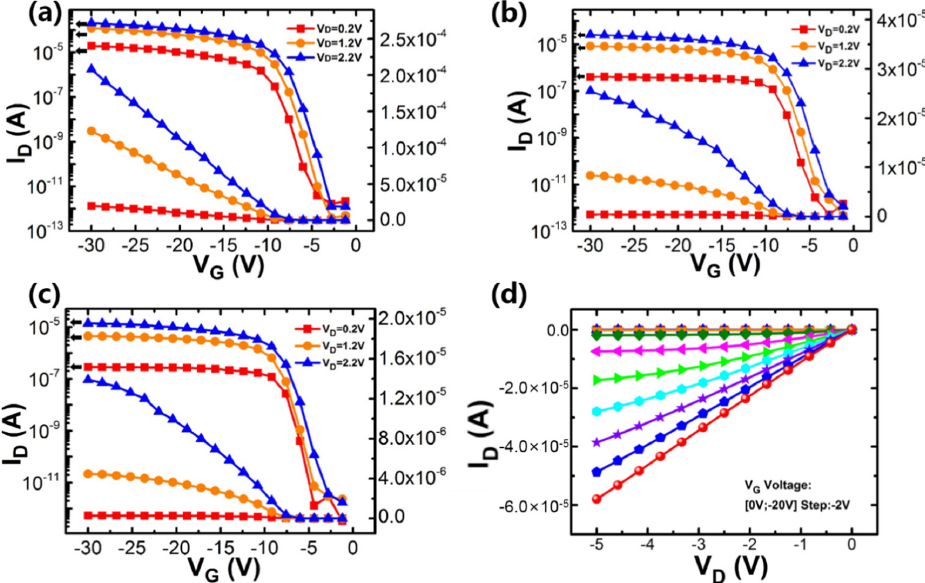
Figure 6. ( a – c ) typical I D -V G curves of the fabricated 5- μ m-L G , 10- μ m-L G and 15- μ m-L G p-type SOI Si NW sensors by back gate bias, respectively, ( d ) typical I D -V D curves of the fabricated 10- μ m-L G p-type SOI Si NW sensors.